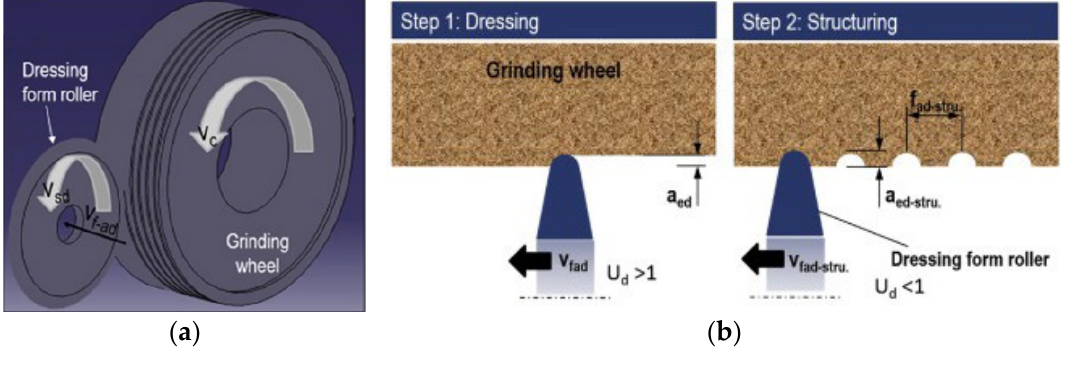
Figure 6. Illustration of the texturing process of the grinding wheel: ( a ) flattening the grinding wheel with standard dressing, followed by specific conditioning to form macrostructures on the wheel’s surface ( b ) [45].